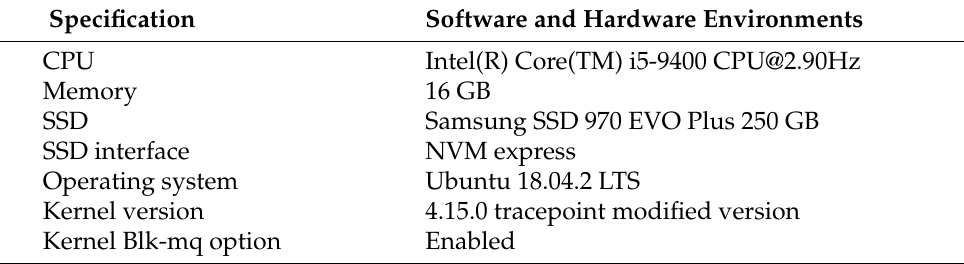
Table 2. Experiment